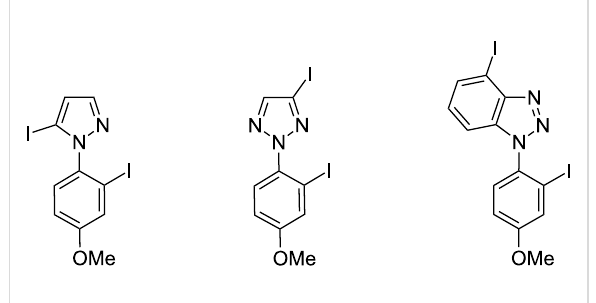
Figure 7: Iodides previously formed as major products from the corresponding N -(4-methoxyphenyl)azoles using the lithium–zinc base.